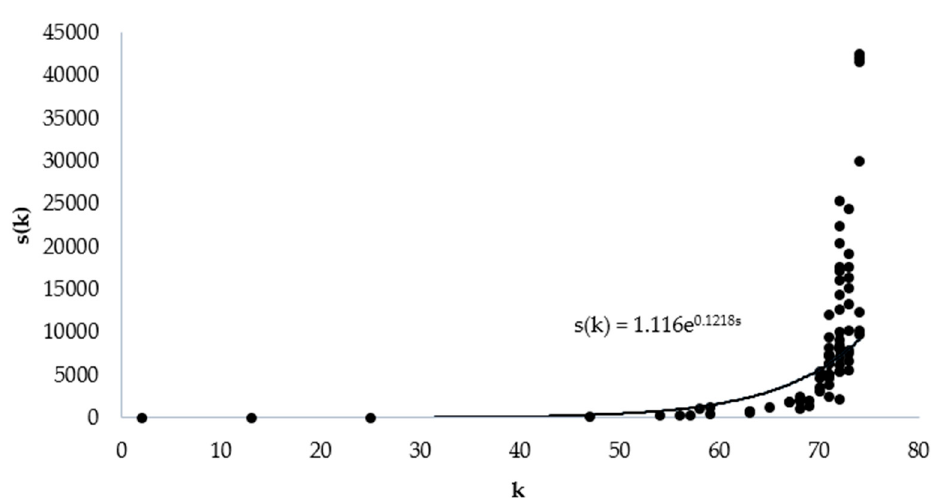
Figure 6. Relationship between node degree and intensity of community learning interest in similar groups.